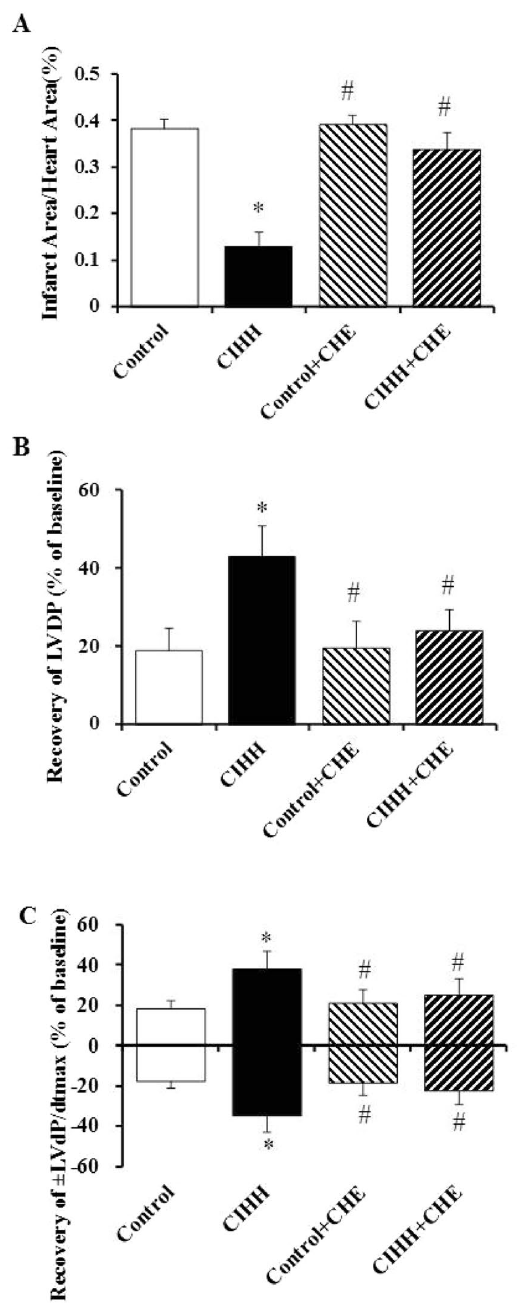
Figure 6. Inhibtion of PKC blocked the CIHH-induced cardiac protection in isolated rat hearts subjected to 30-min ischemia and 60-min reperfusion. ( A ) Infarct size. ( B ) LVDP. ( C ) ± LVdp/dt max . All data were expressed as mean ± SD, n = 6 for each group. * P < 0.05 vs control group. # P < 0.05 vs CIHH